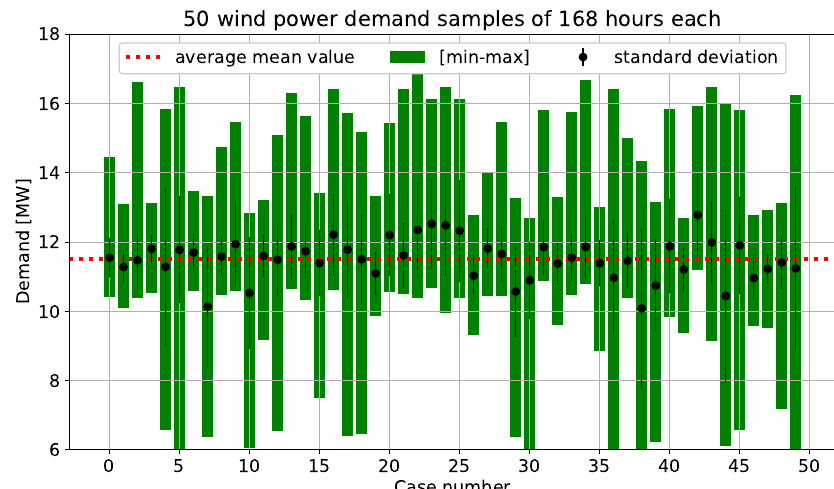
Figure 15. Power demand variation for 50 samples containing 7-day records at 100 s